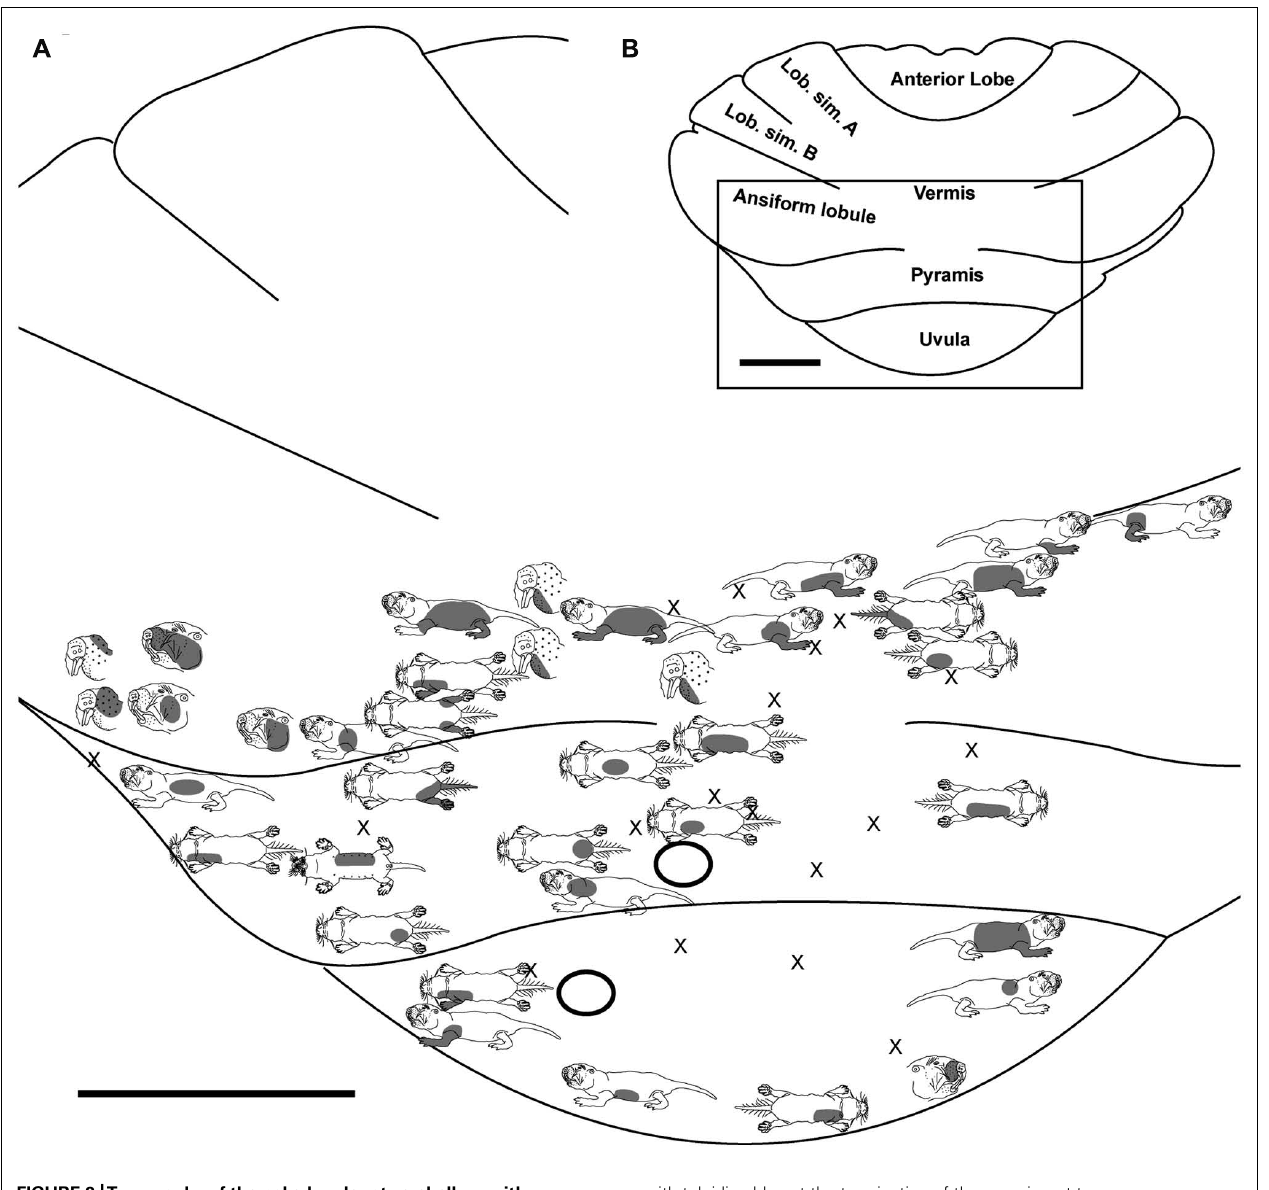
with toluidine blue at the termination of the experiment to serve as anatomical landmarks. “X” marks designate recording sites from which no response was detected. (B) Illustration of the naked mole-rat cerebellum with a box delineating the area exposed by craniotomy. Dorsal view, rostral is up. Animal #031709. Scale bars: 1 mm for both (A,B)